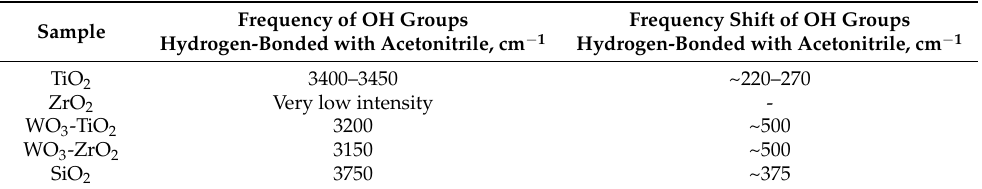
Table 3. Frequency shifts of stretching vibrations of surface OH groups caused by deuteroacetoni- trile